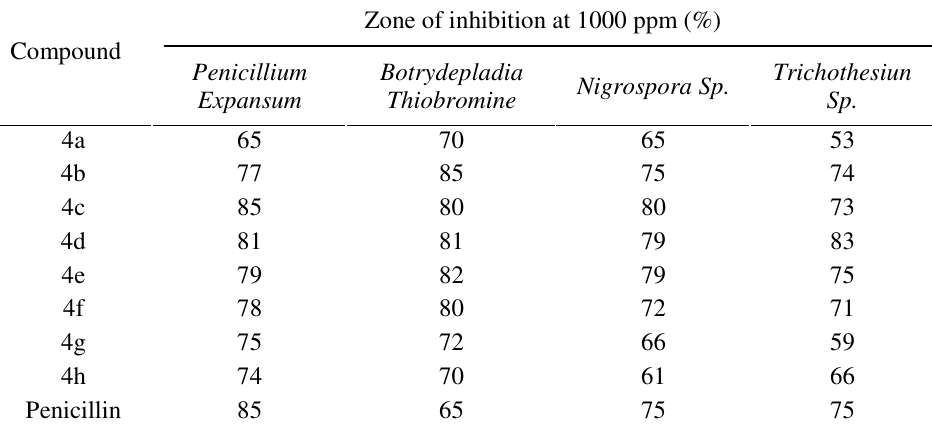
Table 3. Antifungal Activity of compounds 4a-h